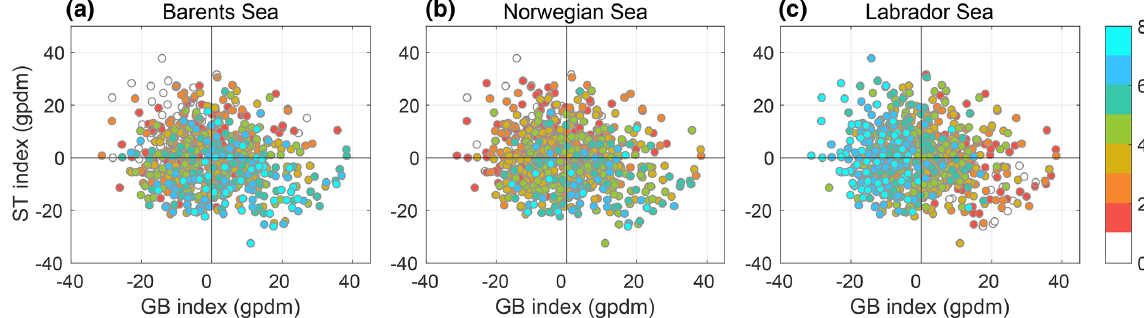
Figure 7. Scatter plot of weekly means of 500hPa geopotential height anomalies (in gpdm) averaged over the GB and ST regions (western- most and easternmost green boxes in Fig. 2d, respectively) during DJFM for (a) the Barents Sea, (b) the Norwegian Sea and (c) Labrador Sea regions. As in Fig. 3, all anomalies are computed with respect to the daily climatology and averaged weekly. Marker colour indicates the mean MCAO index (K) averaged over each of the basins (separately for each